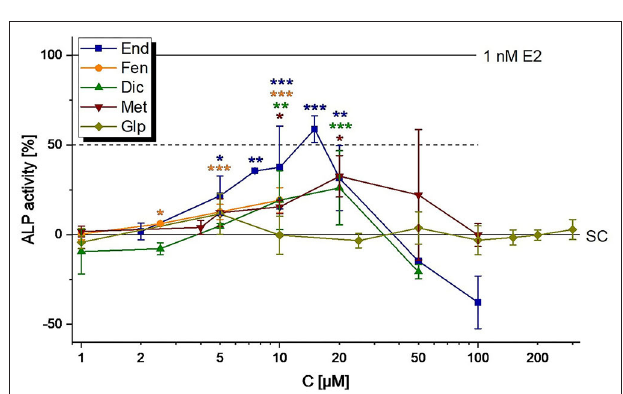
FIGURE 3 | Estrogenicity of representative pesticides (endosulfan, End; fenarimol, FEN; dicofol, Dic; Methiocarb, Met; glyphosate, Glp), as measured in ALP assays. Values were scaled to the solvent control (0%) and the positive control (1nM E2, 100%) and are expressed as means ± SD of at least three independent experiments. Significant differences to the solvent control (SC) were calculated by an one-way ANOVA test for each compound, followed by Fisher LSD post-hoc testing, and are indicated by “*” (p < 0.05), “**” (p < 0.01) or “***” ( p <